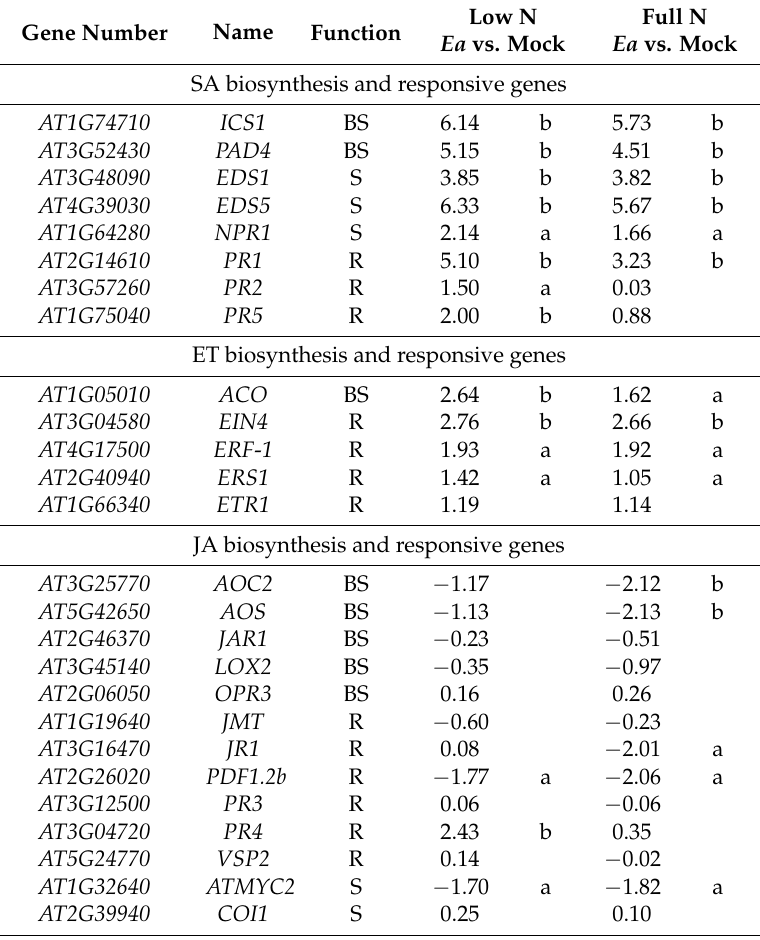
Table 1. Effect of N limitation on defense-related genes. Values are log2 signal ratios between infected and water-treated control plants. BS: Genes involved in hormone biosynthesis, R: Hormone-responsive genes, S: Genes involved in hormone signaling. Two levels of significance threshold were considered according to the Bonferroni statistical test (a: p -value < 0.05; b: p -value < 10 − 8 ).